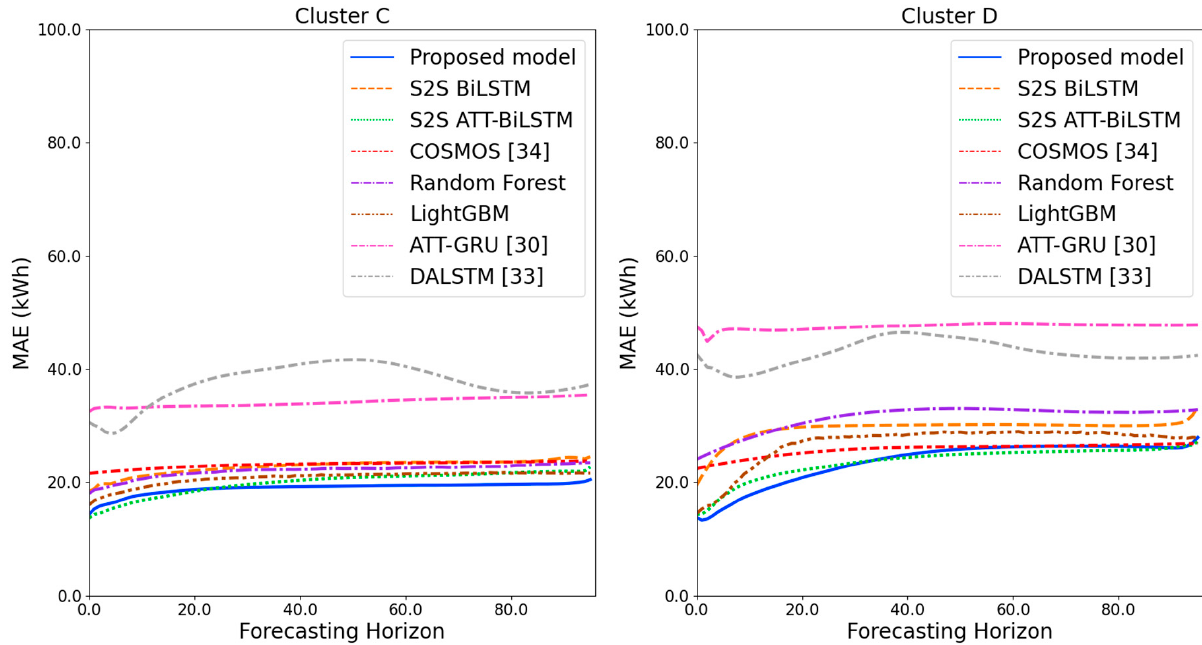
Figure 15. MAE results of clusters A and B over the entire forecasting horizon (kWh).